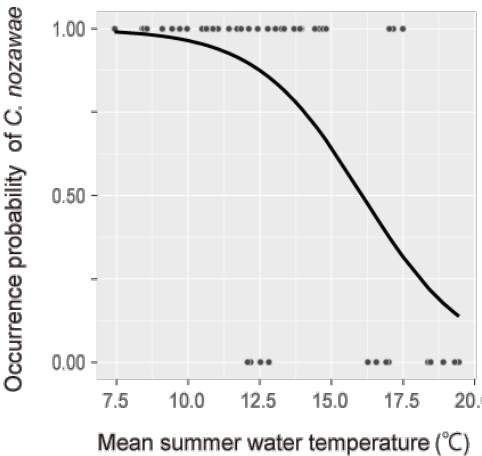
Figure 3. The relationship between the mean summer water temperature and the probability of C.